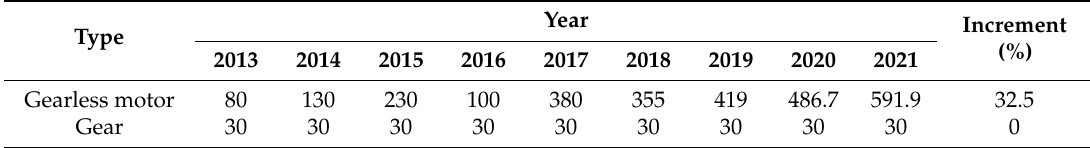
Table 4. Increment percentage of monstrous fan sales forecasting according to fan technology.